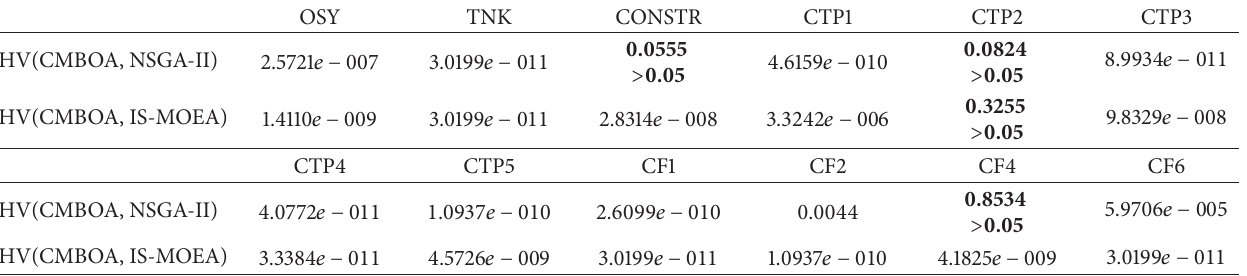
Table 6: Distribution of HV value using Wilcoxon rank-sum